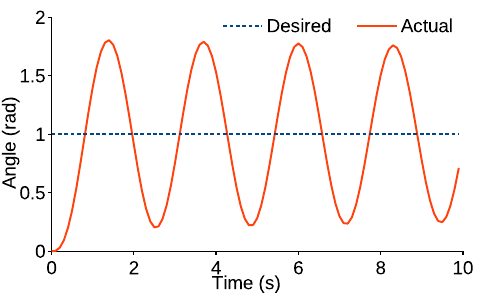
Figure 3. Unit step response for proportional controller for joint 3, in which T u = 1.5 s and K u = 7.